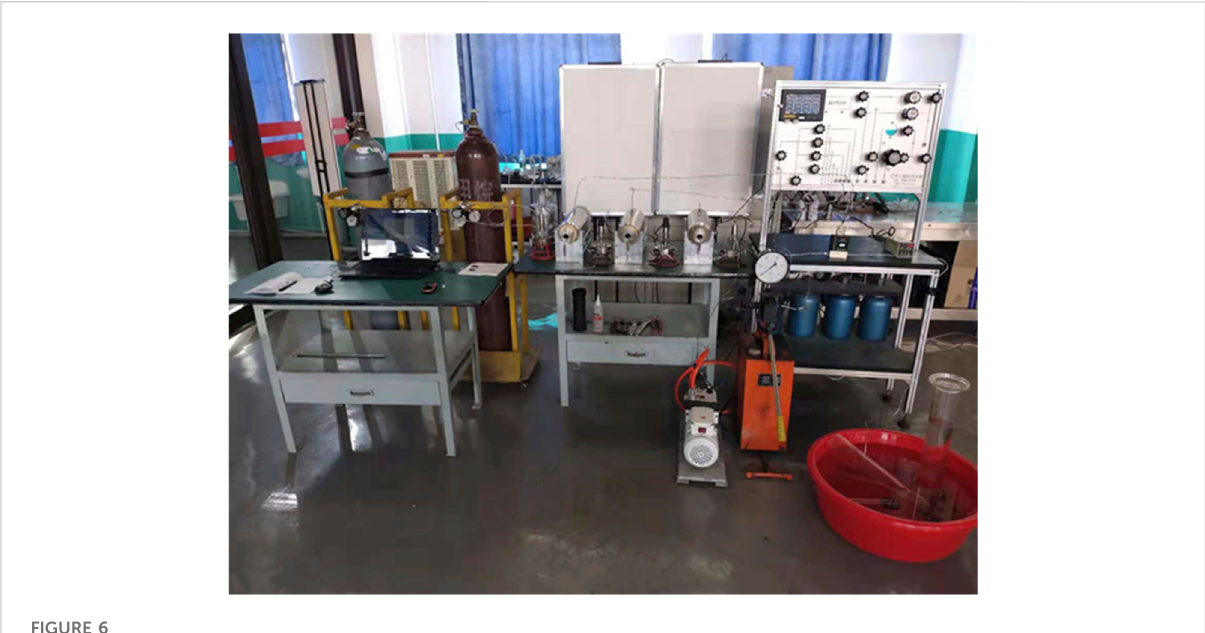
FIGURE 6 Overview of the experimental